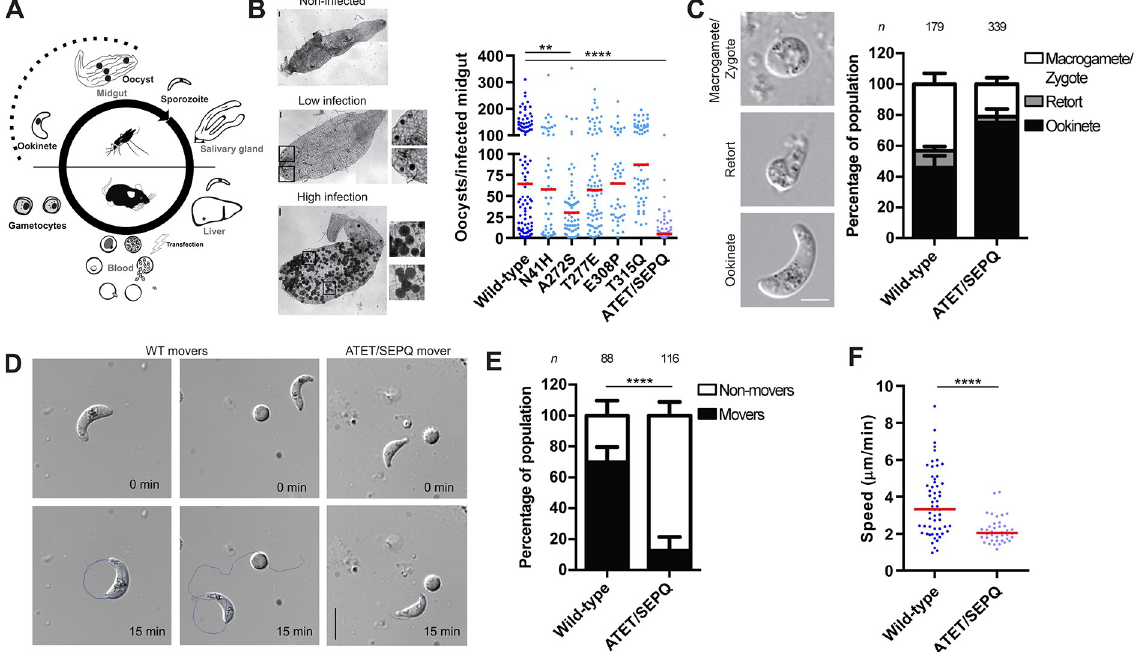
Fig 2. Single mutations of subdomain 2 and 3 have no effect on early mosquito stage infection while a quadruple mutant of subdomain 3 has highly reduced ookinete motility and infectivity. (A) A schematic representation of the life cycle with early mosquito stages indicated with a dashed line. Ookinetes are motile parasites that develop in the mosquito midgut, penetrate the midgut epithelium and subsequently develop into oocysts. (B) Representative images of different oocyst loads observed in mosquito midguts and oocyst loads for different parasite lines. All mutants showed normal ranges of infections with the exception of quadruple subdomain 3 mutant ATET/SEPQ, which was dramatically reduced compared to the control. T315Q had slightly increased oocyst levels (p = 0.03). Red line indicates median value. Mann- Whitney test, �� p < 0.01; ���� p < 0.0001, n � 44 infected midguts from at least 2 mosquito infection experiments. Scale bar: 100 μ m. Midgut images were stitched to form composite image of whole organ. (C) Representative images of ookinete development. After gamete fusion, the round zygote develops through an intermediate retort stage into a mature ookinete. Scale bar: 5 μ m. Quantification of ookinete developmental stages after 21 hours post activation reveals no defect in ookinete development for the ATET/SEPQ mutant. Bars represented as mean ± standard deviation. (D) Representative stills at acquisition start (0 min) and end (15 min) for motile wild-type (WT) and ATET/SEPQ ookinetes. Scale bar: 10 μ m. (E) ATET/SEPQ has a significantly reduced population of motile ookinetes. Bars represented as mean ± standard deviation. Fischer’s exact test, ���� p < 0.0001. (F) Quantification of speeds for motile parasites indicated that the motile population of the ATET/SEPQ mutant line moved slower than wild-type. Red line indicates median value. Mann-Whitney test, ���� p <